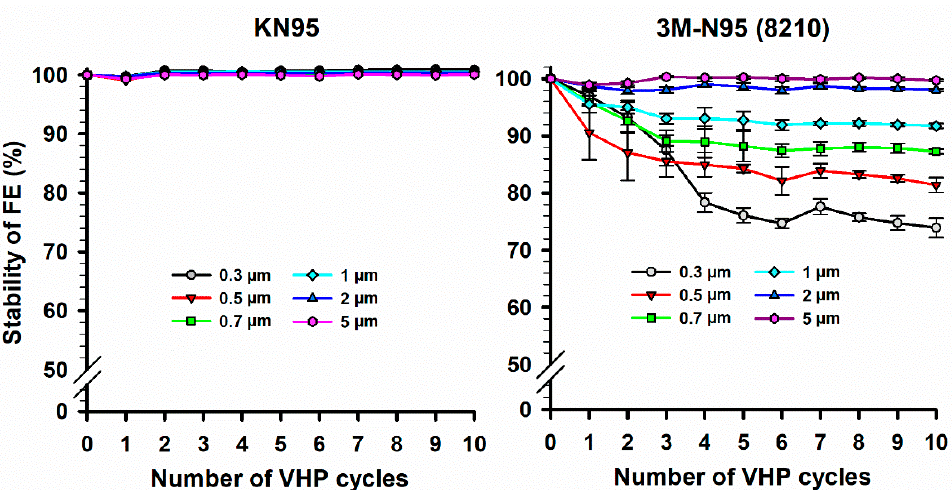
Figure 3. Stability of filtration efficiency (FE) of KN95 and 3M-N95 masks over H2O2 decontam- ination cycles. Twelve of each KN95 (left panel) and 3M-N95 (right panel) masks were cycled in VHP-STERIS sterilization systems 10 times. The masks were applied to FE stability evaluation after each VHP cycle for different particle sizes (0.3–5 µ m) using AeroTrak particle counter. Symbols represent the mean, and error bars indicate the standard error. Statistically, the 3M-N95 masks showed an overall significant ( p < 0.001) reduction in FE stability with increased VHP cycles. Pair- wise comparison: 0.3 µ m vs. 5 µ m, p < 0.001; 0.5 µ m vs. 5 µ m, p < 0.001; 0.7 µ m vs. 5 µ m, p = 0.006; 0.3 µ m vs. 2 µ m, p = 0.002; 0.5 µ m vs. 2 µ m, p = 0.002; no other pairwise comparison significant differences were observed. Raw data are listed in Supplementary Materials